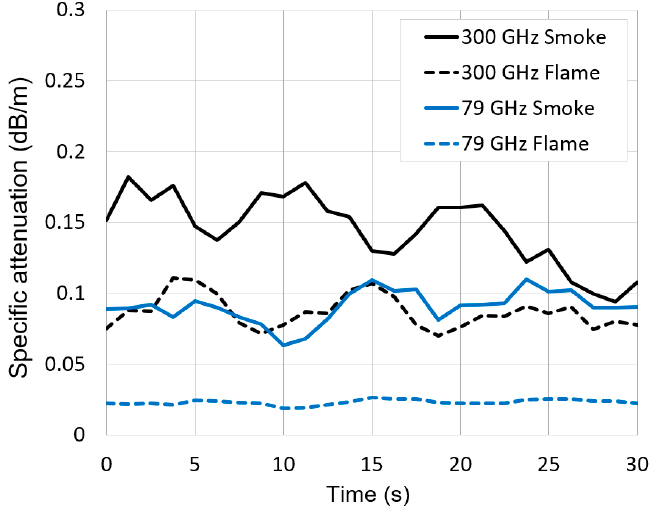
Figure 9. Radar signal measured specific attenuation in smoke and flame versus time. The measured specific attenuation in steam was compared with theoretical